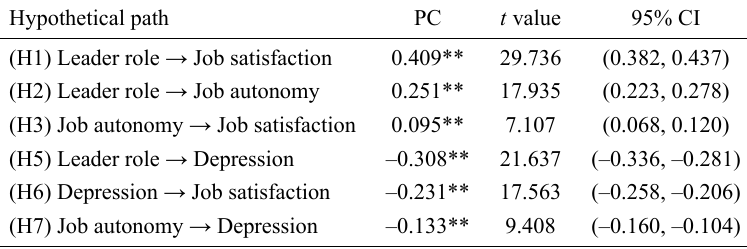
Table 4. Results of hypotheses testing in non-regular employees.